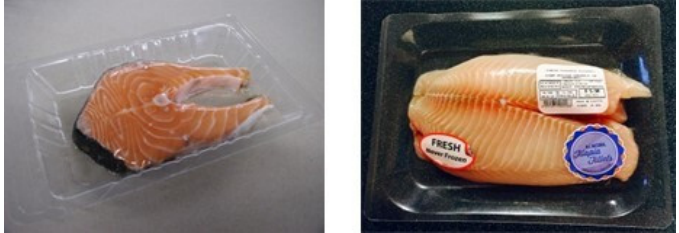
Figure 1. Application of vacuum skin packaging to seafood products (Packaging Europe)